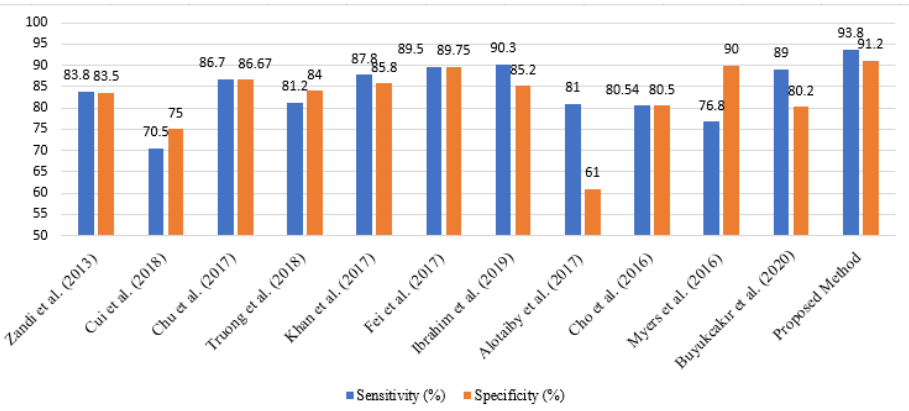
Figure 5. Comparison of results with recent techniques proposed by researchers [36–39,41–46,74].